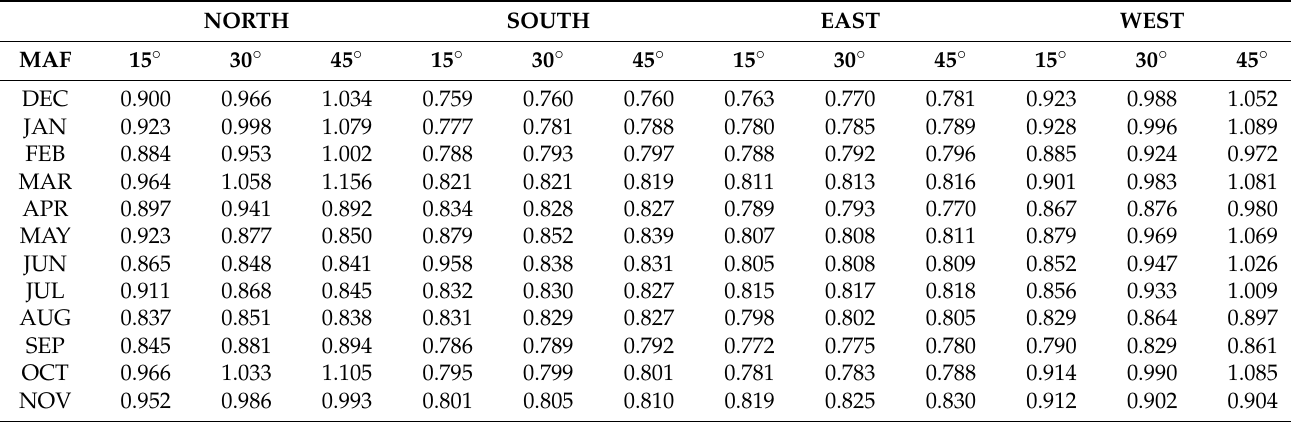
Figure 5. Photopic illuminance (lux) values measured depending on the season (from December 2018 to November 2019); orientation of north ( top ), east ( right ), south ( down ), and west ( left ); and elevation from the horizontal level of 15° (black), 30° (striped), and 45° (grey). Table 2. Melanopic Action Factor (MAF) values calculated depending on the season (from December 2018 to November 2019); orientation of north, east, south, and west; and elevation from the horizontal level of 15 ◦ , 30 ◦ , and 45 ◦